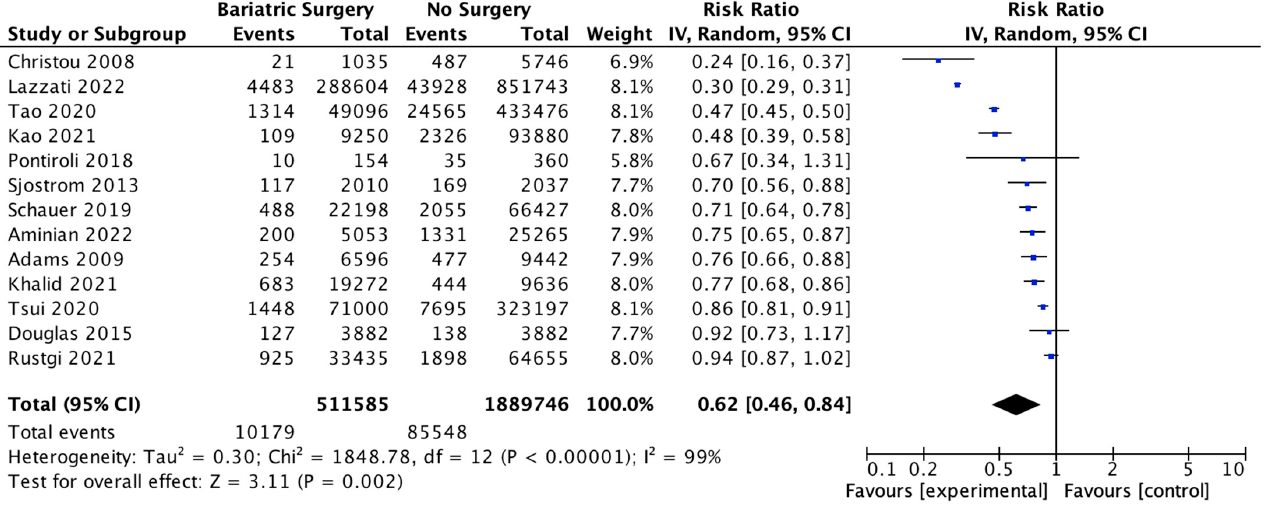
Figure 3. Overall cancer incidence RE analysis [38–44,46–50,66].